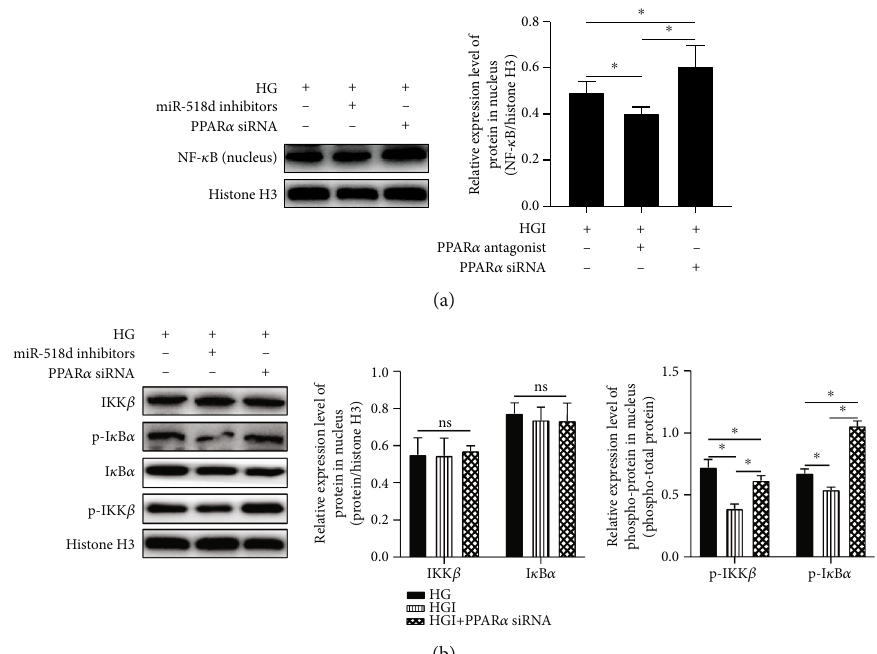
Figure 4: Regulatory mechanisms of miR-518d through the PPAR α -mediated NF- κ B pathway in HTR8/SVneo cells. (a) Expression levels of NF- κ B in the cell nucleus and (b) pathway-related proteins including the levels of phosphorylation detected by Western blotting. All data were represented as mean ± SD . ∗ p < 0 : 05 , ns p > 0 : 05